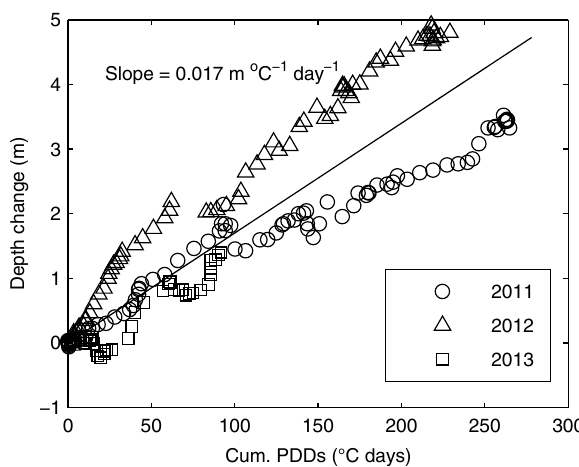
Figure 7. Correlation between the cumulative number of PDDs and the change in depth of the epishelf lake. Depth is estimated from the isotherm proxy during the melt season in 2011, 2012, and